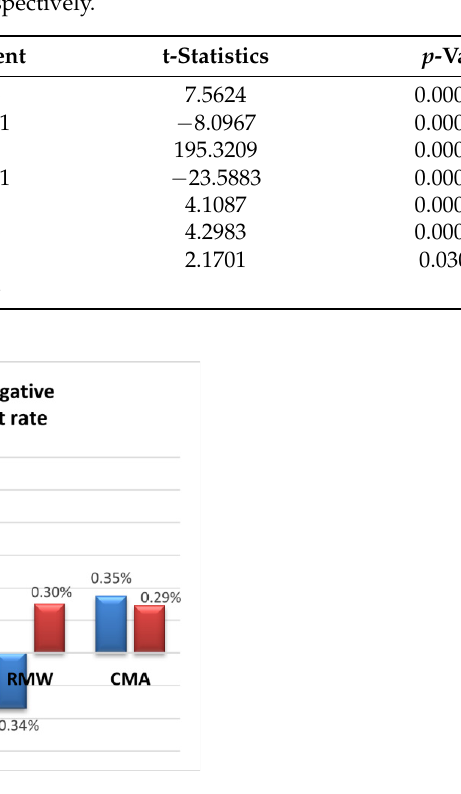
Figure 4. Average five-factor returns in periods of negative and non-negative interest rates.